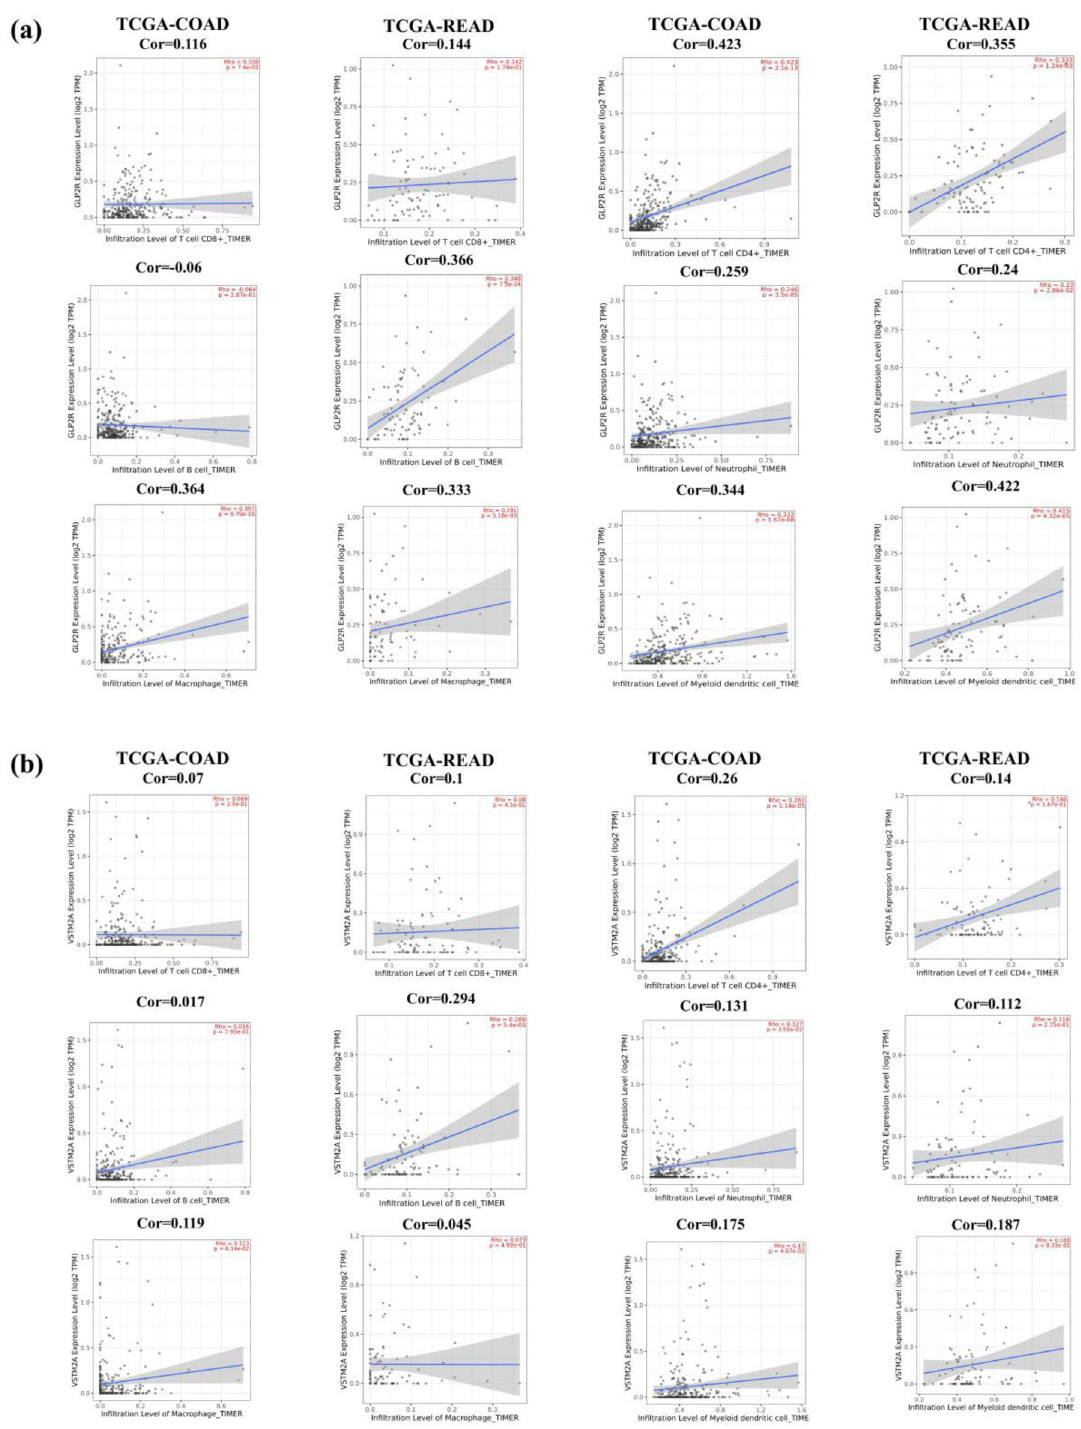
Figure 8. Correlation of final set of genes with immunocyte infiltration. ( a ) The correlation plot of GLP2R and ( b ) VSTM2A with immunocytes for TCGA-COAD and TCGA-READ across different cancer types. It includes 10,897 samples for 32 cancer types from the TCGA repository. It is avail- able at https:// cistr ome. shiny apps. io/ timer/ and TIIC includes an abundance of CD4 + T-cells, CD8 + T-cells, B cells, neutrophils, macrophages, and dendritic cells. In this study, the correlation analysis of TIIC abundance concerning 2 finalized genes in TCGA-COAD and TCGA-READ was explored 23 . ROC Curve and literature analysis. The identified significant features for CRC classification were further analyzed for their receiver-operating characteristic (ROC) curve analysis by using the TCGA-CRC dataset gene